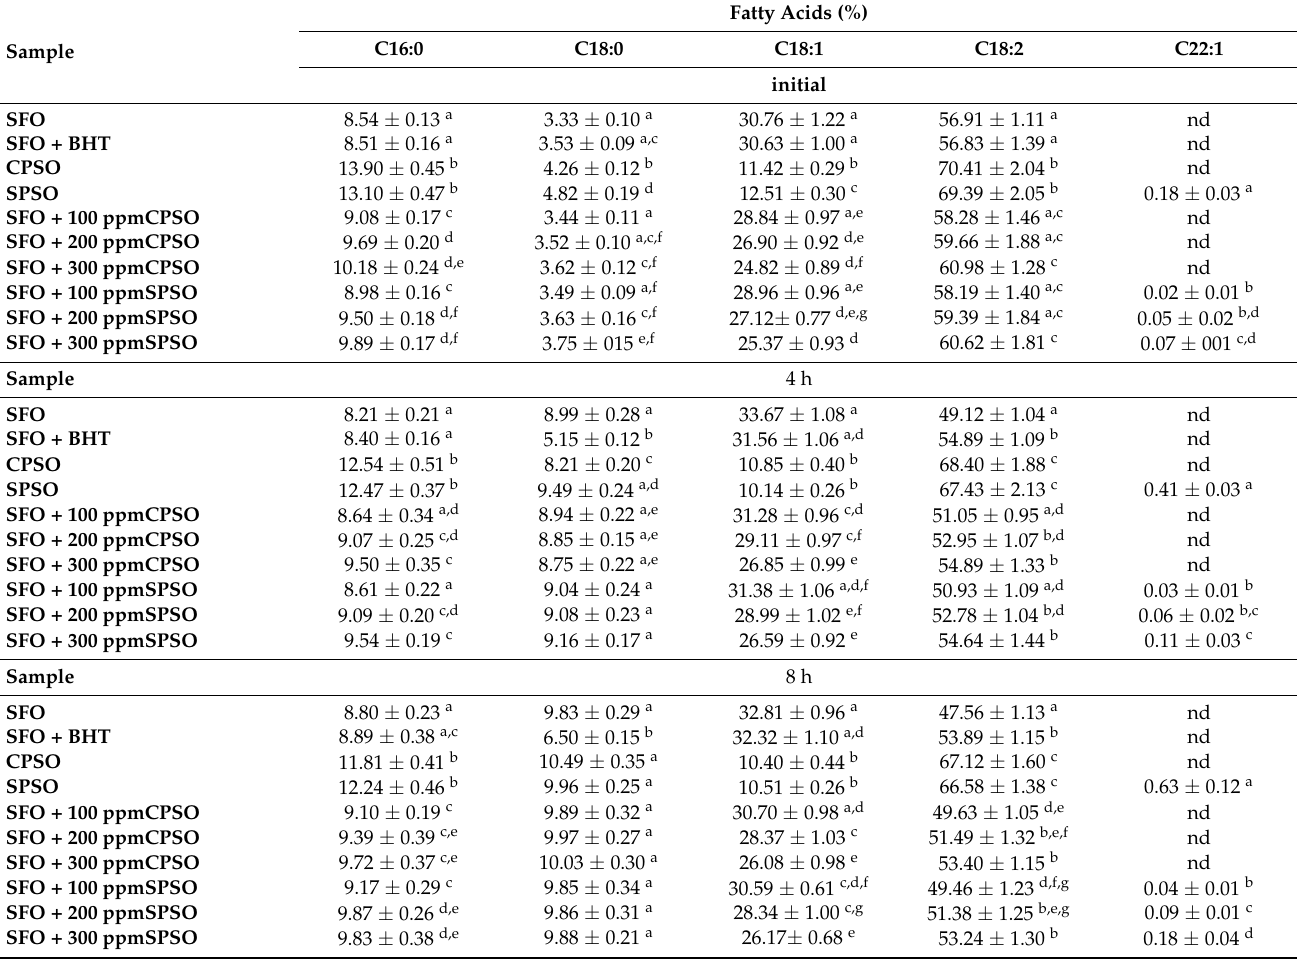
Table 2. The effect of heat treatment for 4 and 8 h on fatty acid composition of oil